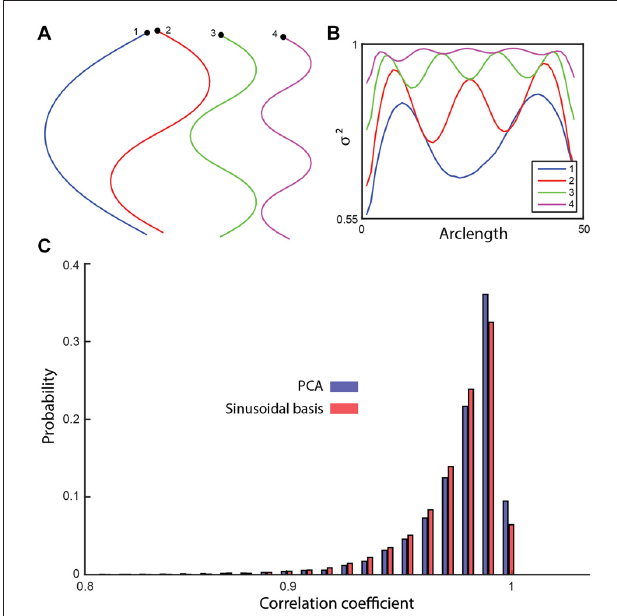
FIGURE 5 | (A) A cosine series was used to generate four basis shapes with increasing frequency. The corresponding x - y representations are shown. (B) The fraction of the variance explained along the worm by including an increasing number of basis shapes. (C) The shapes in the testing set were reconstructed using the four sinusoidal basis shapes and the top four modes of PCA. The histogram of the correlation coefficients (between the reconstructed and the original shapes) suggests a significant, but small difference between the sinusoidal analysis (96.9%) and the data-driven approach (97.1%; t -test, p = 2.49 × 10 − 11